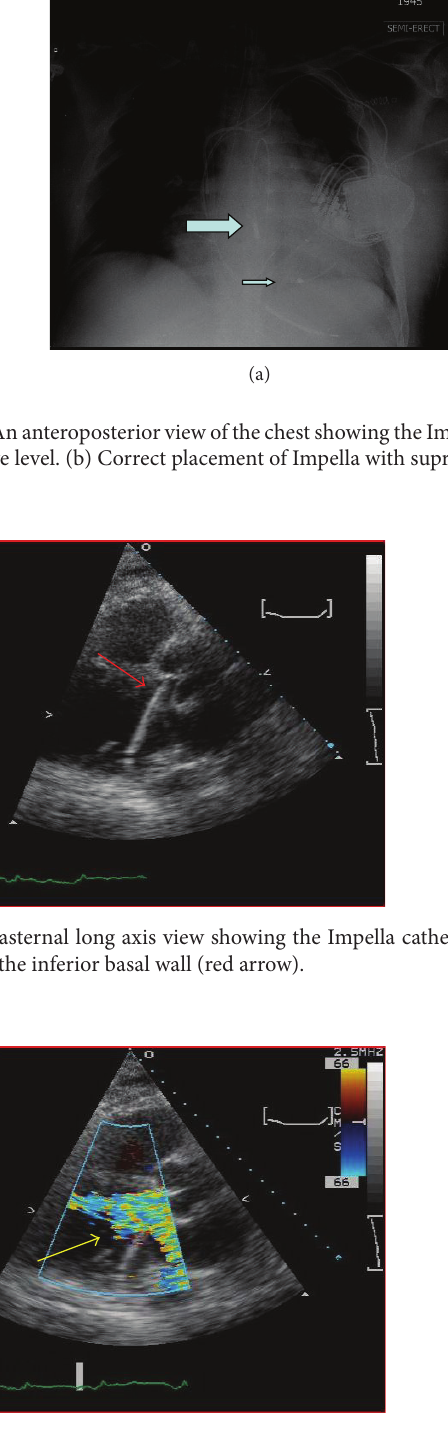
Figure 3: Parasternal long axis view with color flow showing the turbulence of the Impella located subvalvular (yellow arrow).